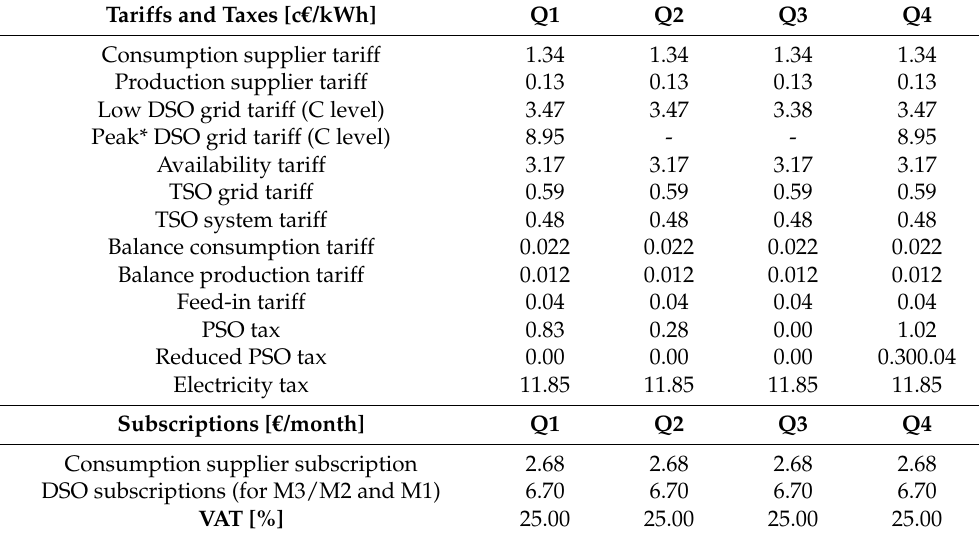
Table 4. Values for the different billing concepts for all the quarters Q1–Q4 in 2019. Self-elaboration.